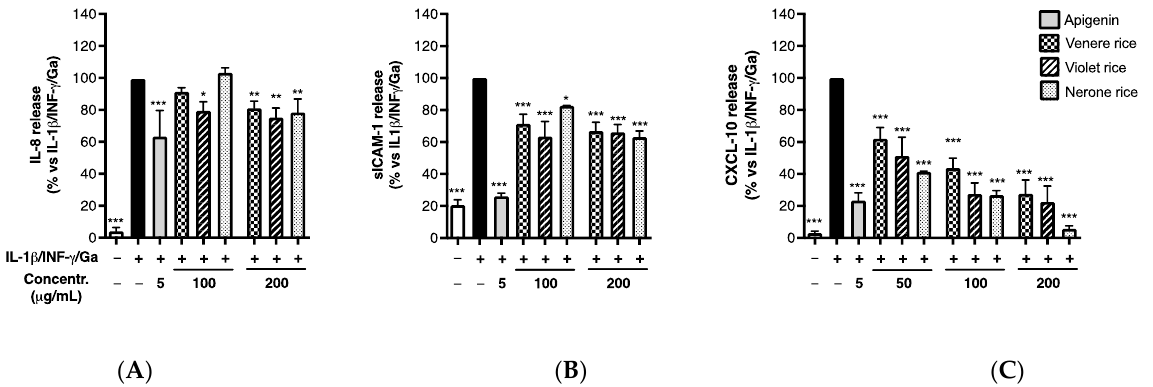
Figure 3. Effect of black rice extracts on IL-8 ( A ), sICAM-1 ( B ), and CXCL-10 ( C ) release. Caco-2 cells were stimulated by IL-1 β (10 ng/mL), IFN- γ (10 ng/mL), and in vitro digested gliadin (Ga) (1 mg/mL) for 6 h. Unstimulated condition was also reported (white bar, Control − ). The release of inflammatory mediators in cell culture media was measured by ELISA assay and expressed as mean of release (% ± SEM) vs. stimulus (black bar, Control+), to which was arbitrarily attributed the value of 100%. * p < 0.05, ** p < 0.01, *** p < 0.001 vs. stimulus. Table 3. IC 50 s of extracts from black rice varieties (Ve, Vi, Ne) on CXCL-10 release. Black Rice Variety IC 50 (μg/mL) Ve